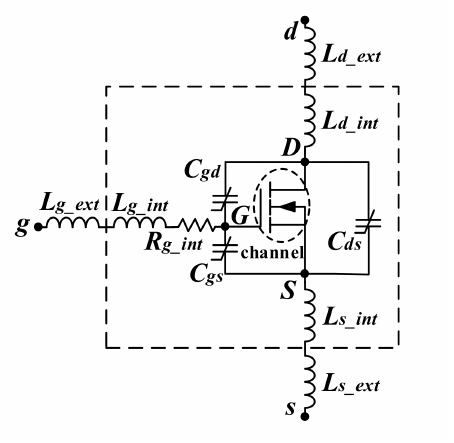
Figure 2. Equivalent circuit of